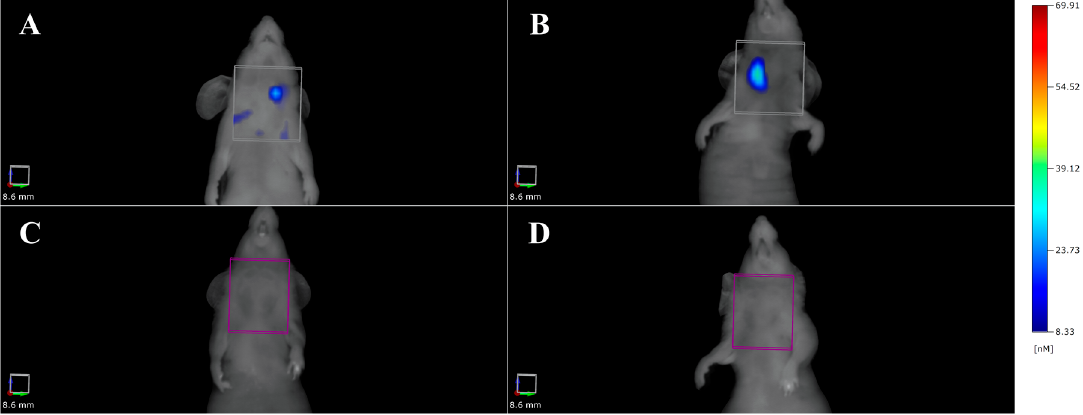
Figure 1. Fluorescent molecular tomography (FMT) of orthotopic ATC bearing mice injected with a 750 nm dye labeled with anti-CD44 antibody ( A , B ) or with the unlabeled dye ( C , D ). In ( A ): 2 h after injection of the anti-CD44 labeled dye, diffuse signal is present in the neck region, with some uptake in the normal thyroid lobe. In ( B ): after 6 h, the probe is specifically concentrated into the neoplastic lobe. In ( C ) and ( D ): the control mouse injected with the unlabeled probe and 2 and 6 h after the injection, respectively; no signal was identified in the neck region.